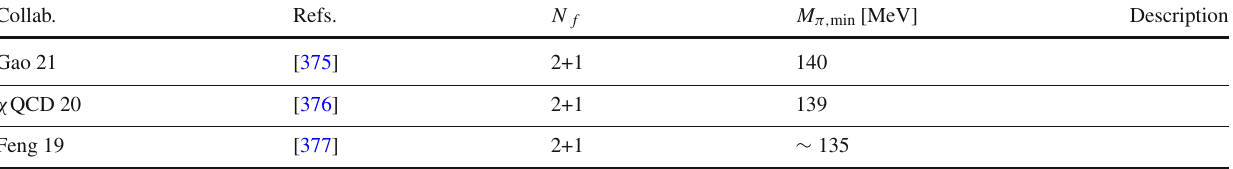
Table 115 Chiral extrapolation/minimum pion mass in determinations of the low-energy constants related to ππ scattering Collab.